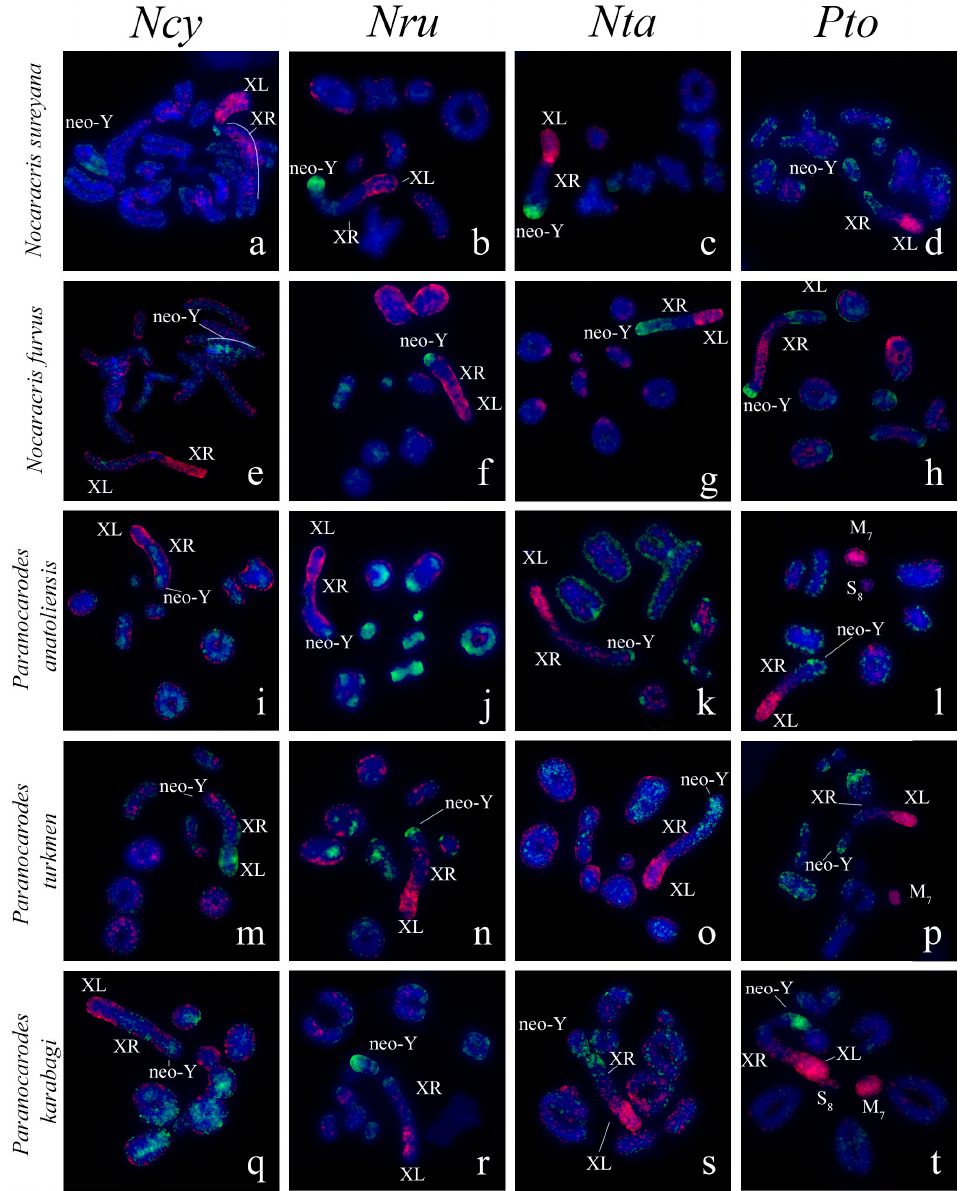
Figure 6. Results of VISSIS analysis of the chromosome plates shown on the of Figure 4. XL indicates short arm of neo-X that corresponds to ancestral X chromosome, XR indicates long arm of neo-X chromosome derived from autosome fusion. Neo-Y indicates corresponding chromosome Names of species indicated in rows and name of probes indicated in columns. ( a – d ) Nocaracris sureyana ; ( e – h ) Nocaracris furvus ; ( i – l ) Paranocarodes anatoliensis anatoliensis; ( m – p ) Paranocarodes turkmen ; ( q – t ) Paranocarodes karabagi .